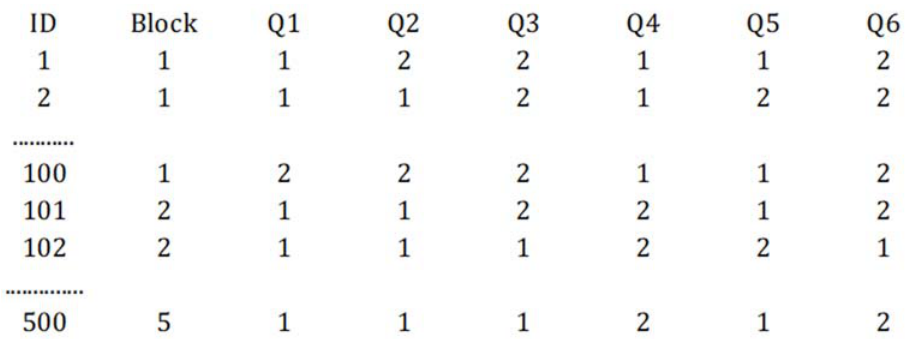
Figure 3. Structure of the responses matrix.